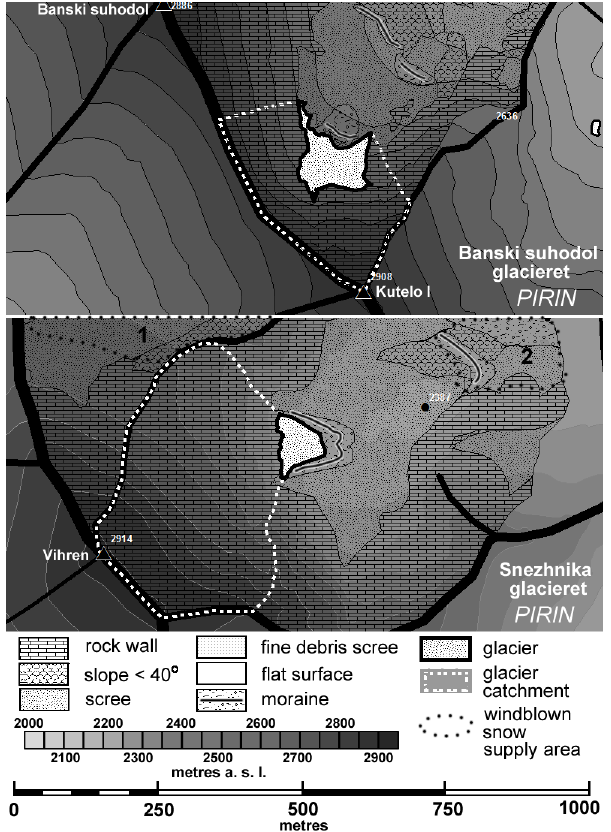
Figure 4. Topographic and geomorphological setting of Pirin glacierets. Banski suhodol glacieret is located on a northern exposure, at high elevation, which provides for relatively low temperatures all year round. Such a location is among the most favorable for annual preservation of snow and ice, at least in Bulgaria, and suggests for relatively stable local climate conditions.